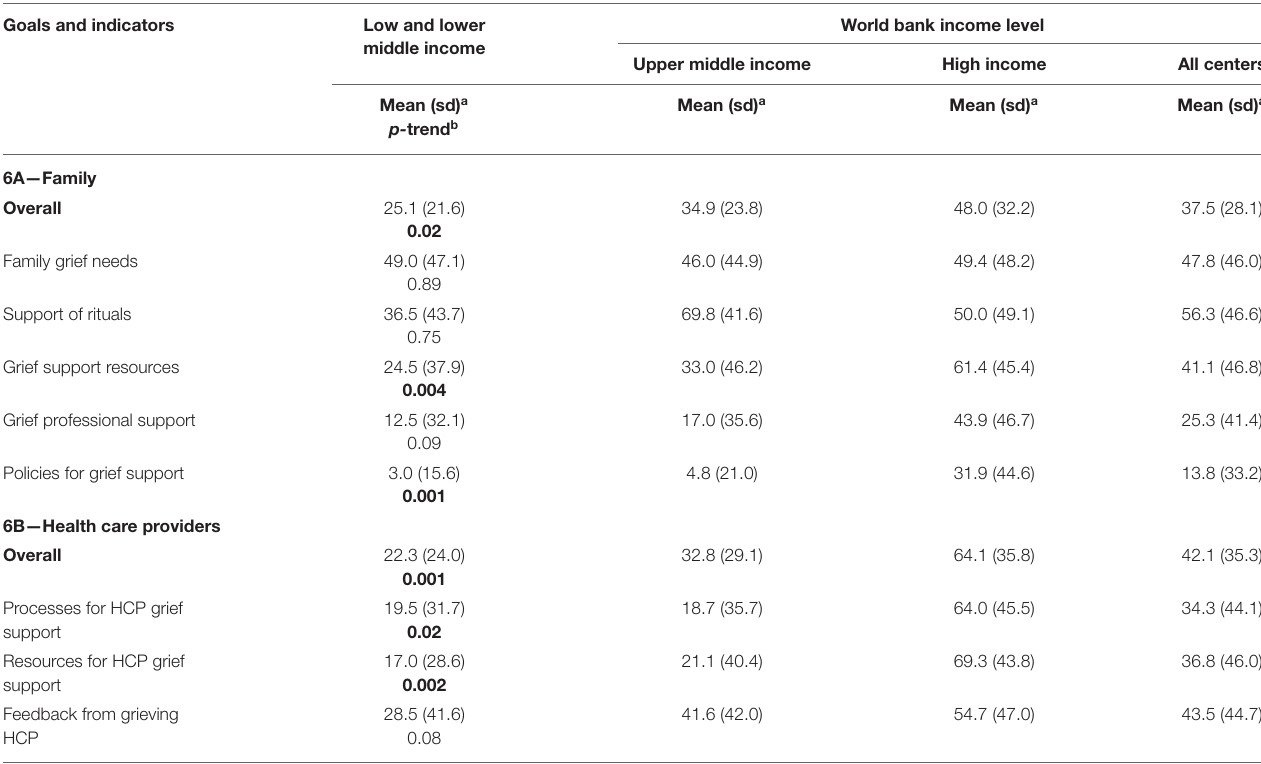
TABLE 1 | Grief and bereavement support goals (6A and 6B) and indicators according to World Bank income level classification. Goals and